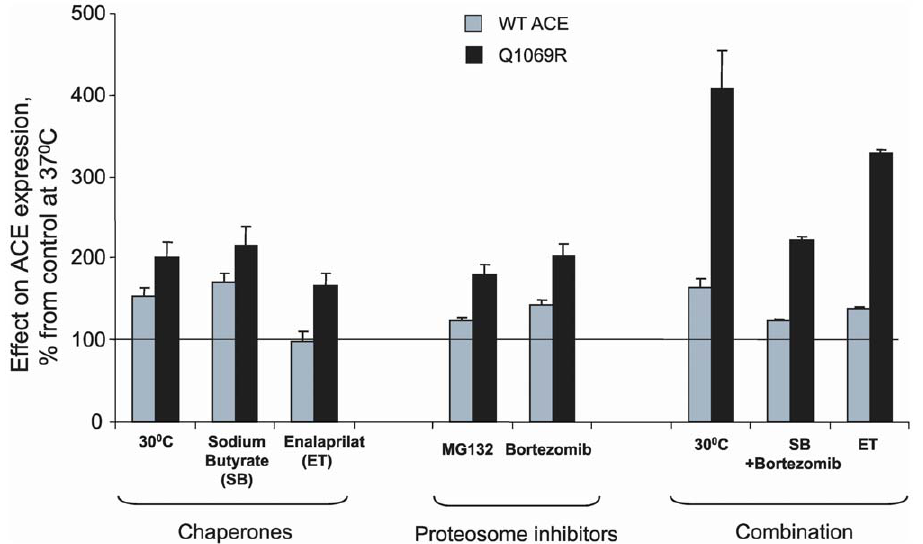
Figure 11. Effect of temperature, chaperones, and proteolytic inhibitors on ACE activity. ACE activity of membrane-bound form of WT and mutant ACE after culturing cells 24 hrs in different conditions listed below as described in Materials and Methods. ACE activity was determined by fluorimetric assay as described in the legend to Figure5 using Z-Phe-His-Leu (ZPHL) as substrate. The following compounds were tested: Sodium butyrate (5 mM); Enalaprilat (1 m M), MG132 (5 m M), Bortezomib (5 m M). Data are the mean values ( 6 SD) of 3–4 independent experiments measured in duplicate expressed as the percentage of ACE activity in the lysate of WT or mutant ACE expressing cells cultured at 37 u C.